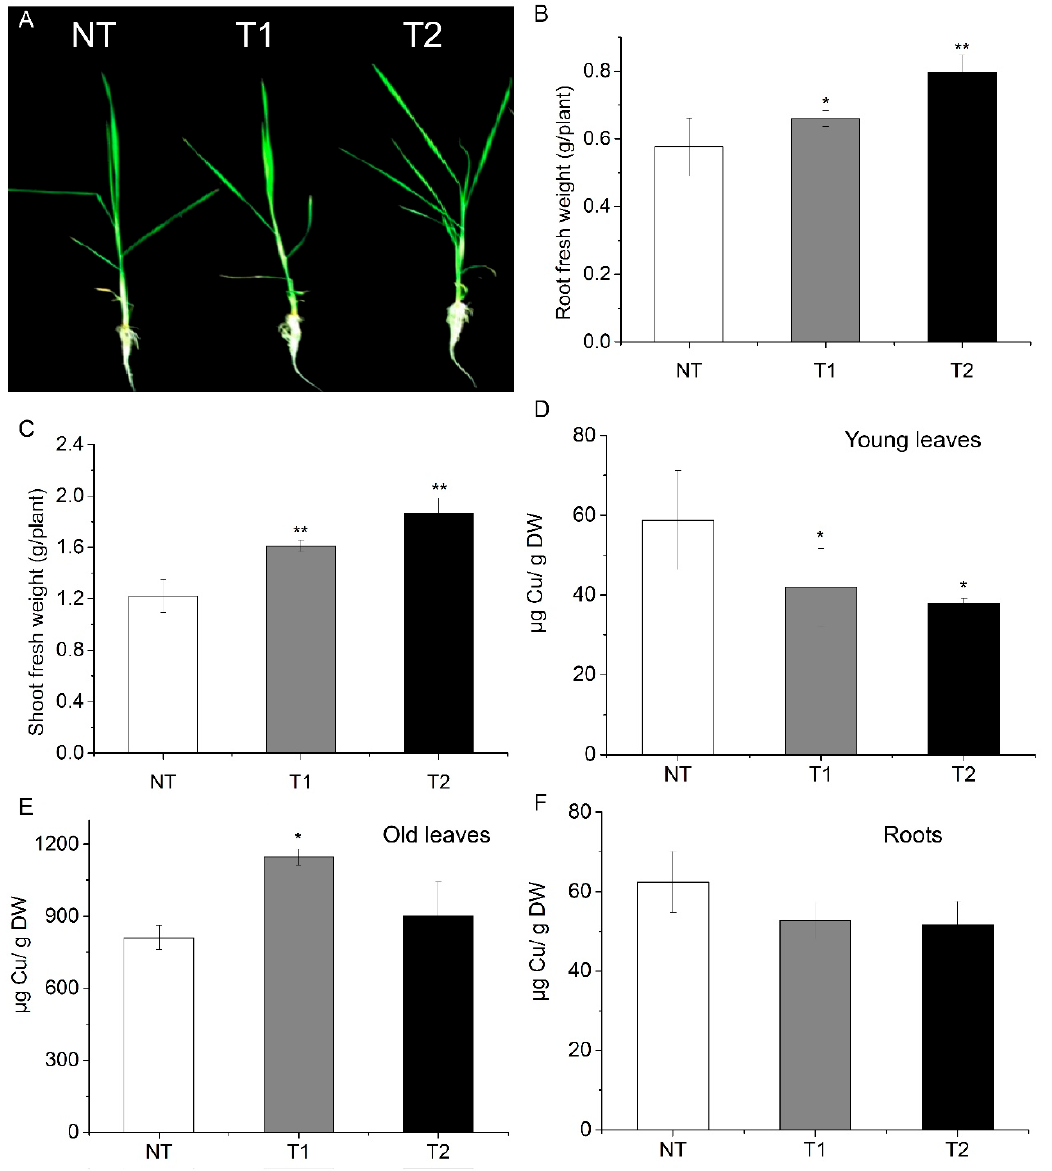
Figure 6. High AhYSL3.1 expression in rice plants resulted in tolerance to excess Cu. Rice plants were treated with 100 µ M Cu for 6 days. ( A ) Phenotypes of transgenic rice plants expressing AhYSL3.1 in response to excess Cu. NT, non-transformed plants; T1 and T2, transgenic lines. ( B , C ) Fresh weights of roots ( B ) and shoots ( C ) of NT and transgenic rice plants after exposure to excess Cu. ( D – F ) Cu concentrations in young leaves ( D ), roots ( E ), and old leaves ( F ) of NT and transgenic lines treated with 100 µ M Cu. Values are means of four biological replicates. Error bars indicate SD. Significant differences from NT were determined by Student’s t -test, * p < 0.05, ** p < 0.01.